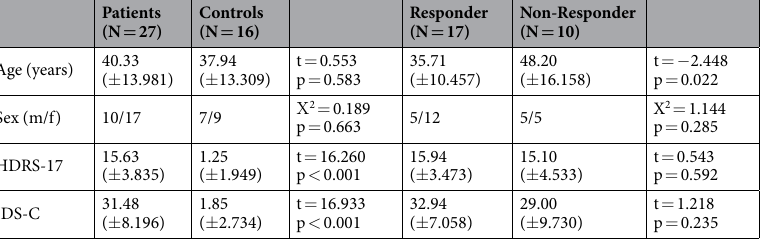
Table 1. Baseline-characteristics of patients versus healthy controls (left) and of depressed patients responding versus non-responding to partial sleep deprivation (right). Shown are means ( ± standard Deviations). Annotations: HDRS-17 = Hamilton Depression Rating Scale (17 item version); IDS-C = Inventory of Depressive Symptomatology (Clinician